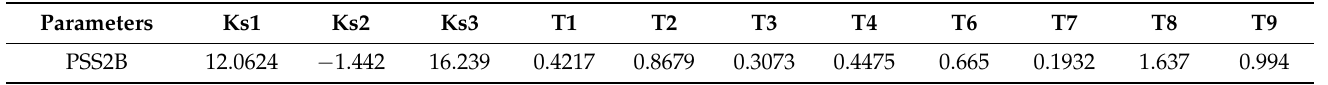
Table 4. Optimal parameter values of dual-input power system stabilizer using ALO.